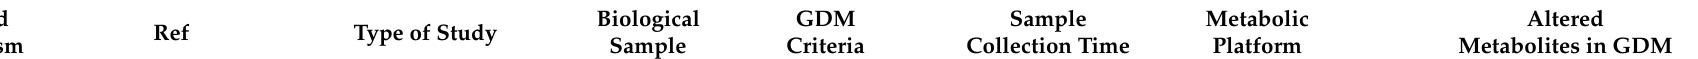
Table 1. Selected metabolomics studies in gestational diabetes